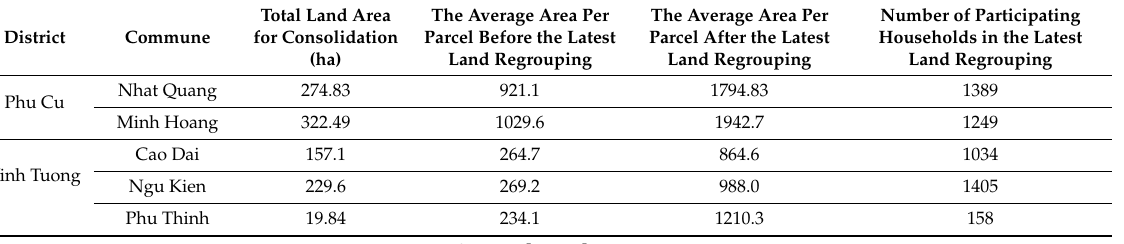
Table 6. The transformation of agricultural land parcels after land regrouping in the case studies.